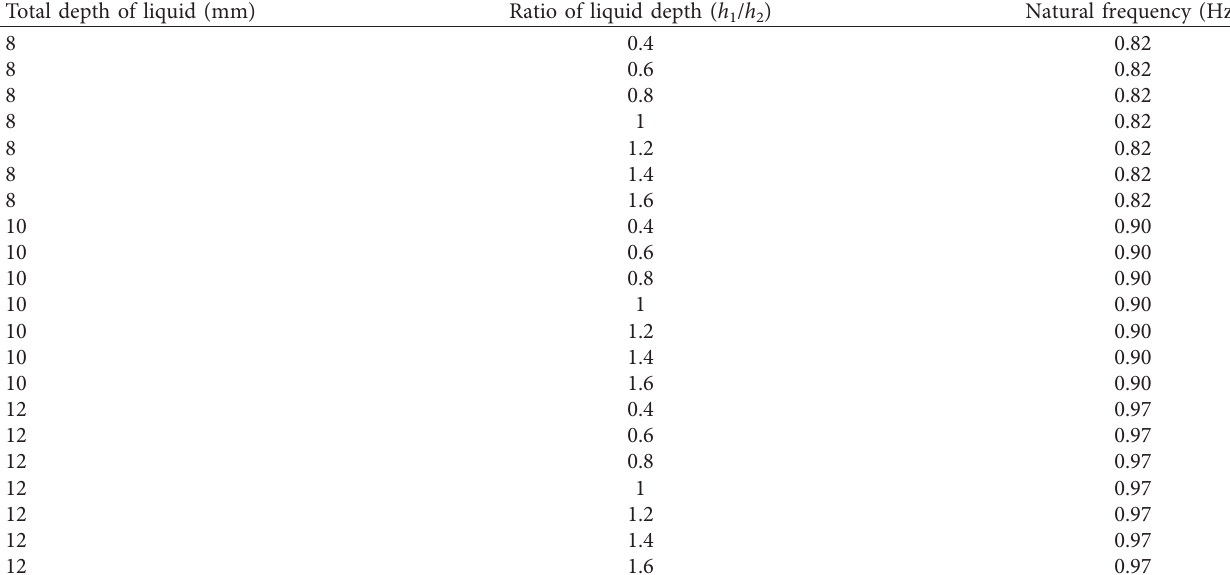
Figure 5: Maximum pressure amplitude with various exciting frequencies. Table 1: Natural frequencies of stratified liquids